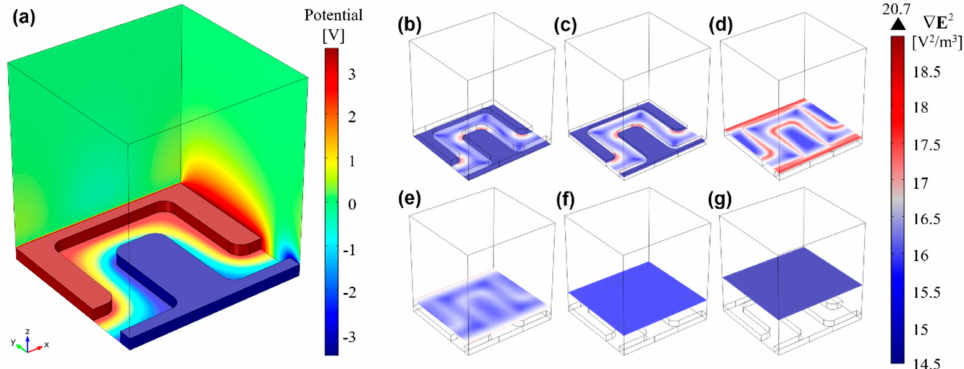
Figure 4. 3D finite element analysis of ( a ) the electric potential distribution (V), gradient magnitude of the electric field squared, ∇ ( E · E ) (logarithmic scale), and trapping regions at different xy -planes: ( b ) 0 µ m; ( c ) 2.5 µ m; ( d ) 5.5 µ m; ( e ) 9.5 µ m; ( f ) 15.5 µ m; ( g ) 27.5 µ m. From these results, it is foreseen that microalgae experiencing pDEP will be drawn towards the outward electrode corners and edges (highest ∇ ( E · E ) regions), whereas those cells undergoing nDEP will be projected towards upper microchannel planes (lowest ∇ ( E · E )